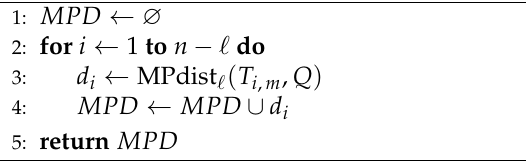
Algorithm 3 MP DIST P ROFILE ( IN T , Q ; OUT MPD